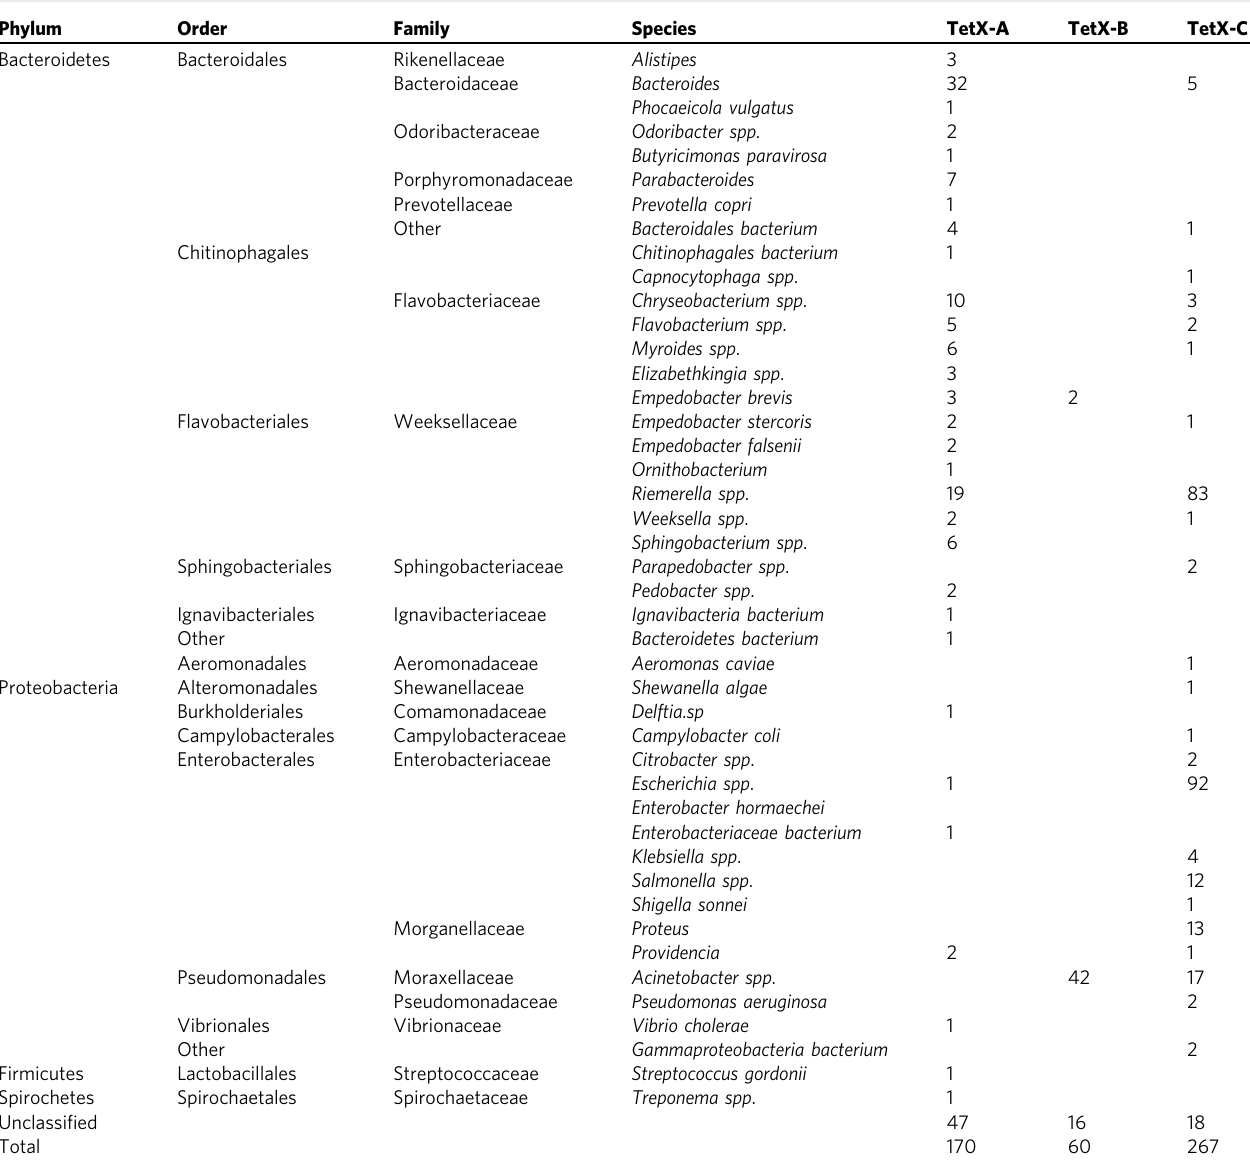
Table 3 Distribution and relative prevalence of newly de fi ned tet X-A, tet X-B and tet X-C genes among different bacterial species.